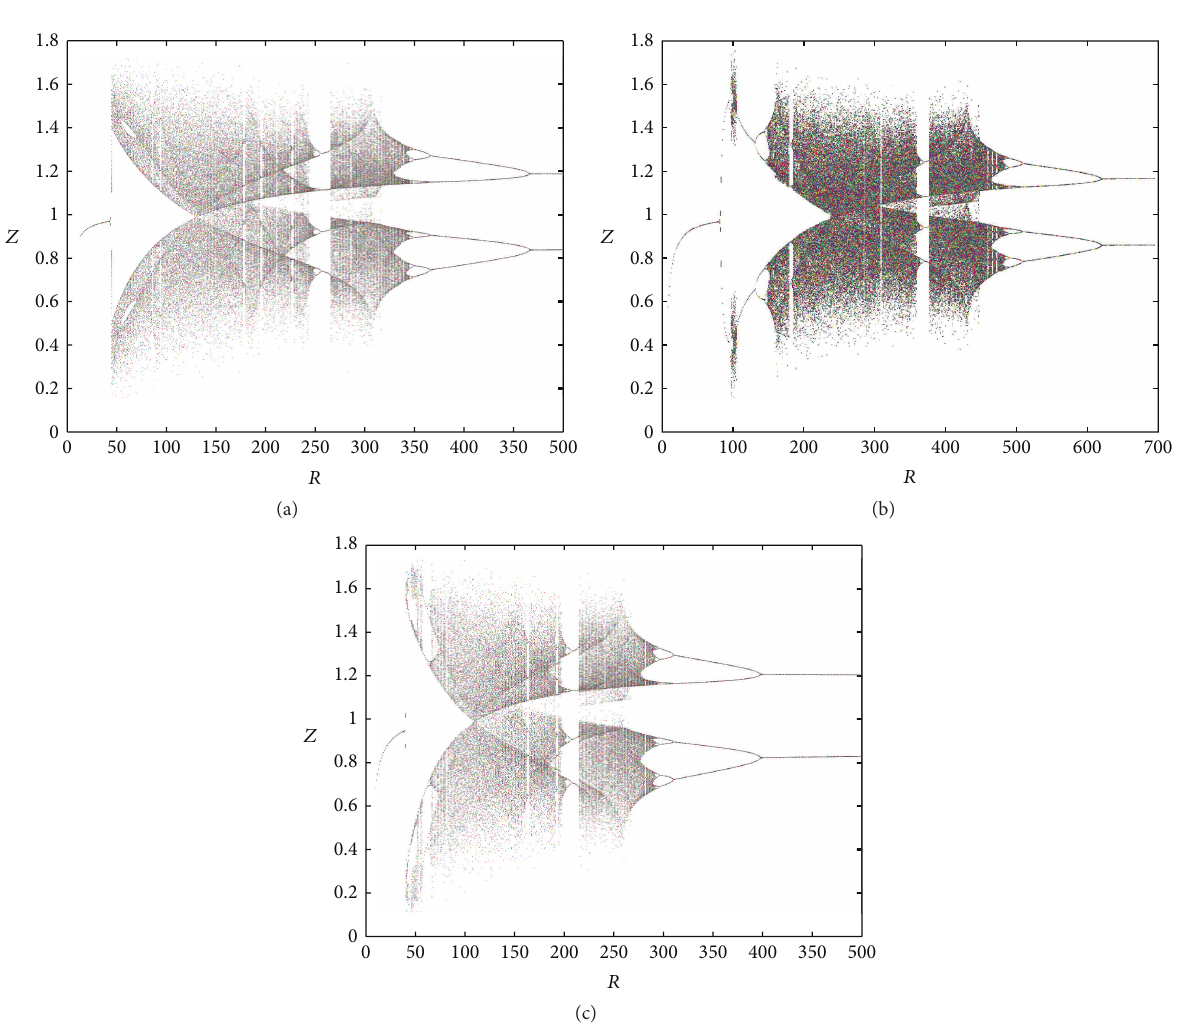
Figure 4: Bifurcation diagrams for (a) Le = 0.1 , 𝑅 𝑠 = 15 , (b) Le = 0.1 , 𝑅 𝑠 = 30 , and (c) Le = 0.4 , 𝑅 𝑠 = 15